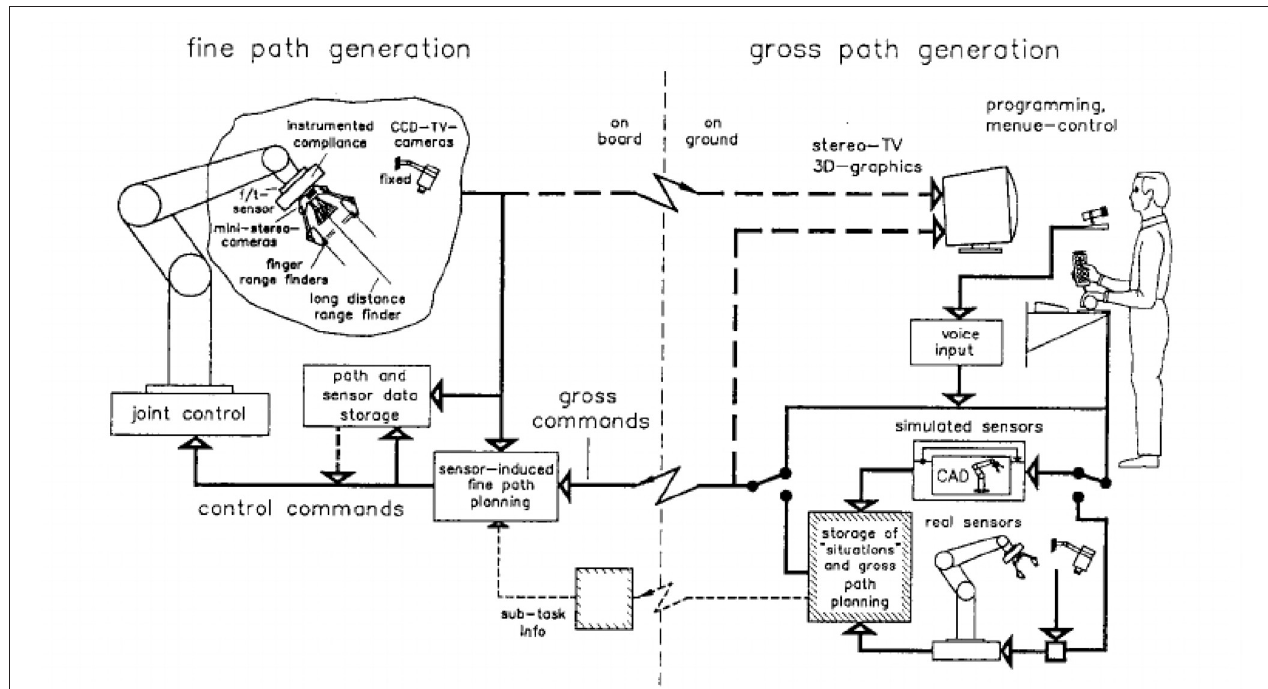
FIGURE 5 | The overall loop structures for the sensor-based telerobotic concept of the ROTEX experiment (Hirzinger et al., 1993). [ © 1993 IEEE. Reprinted, with permission, from (Hirzinger et al., 1993)].